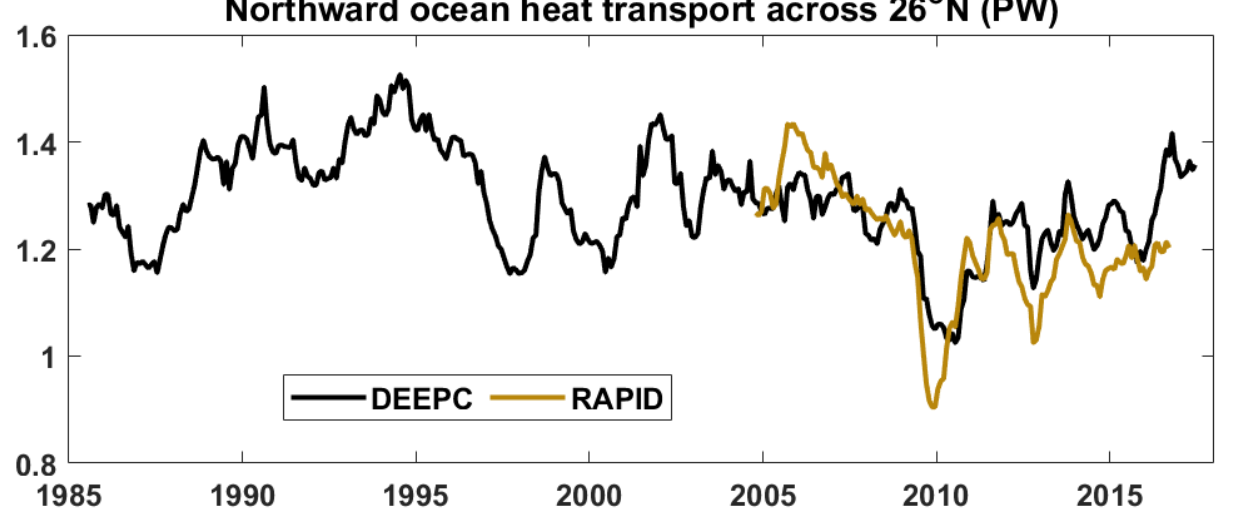
Figure 4. Northward meridional ocean heat transports at 26 °N in the Atlantic. The DEEPC net surface fluxes are in black and RAPID observations are in brown.